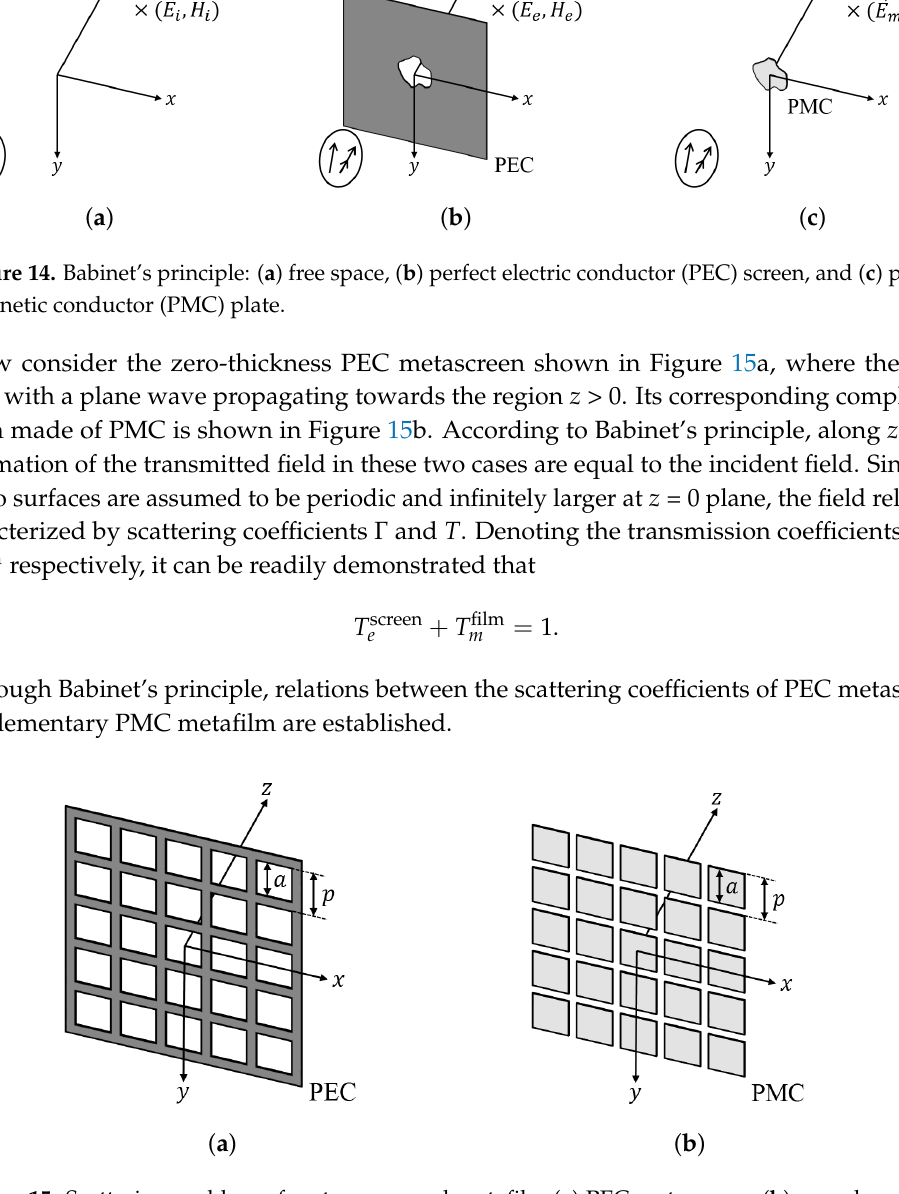
Figure 15. Scattering problem of metascreen and metafilm ( a ) PEC metascreen, ( b ) complementary PMC